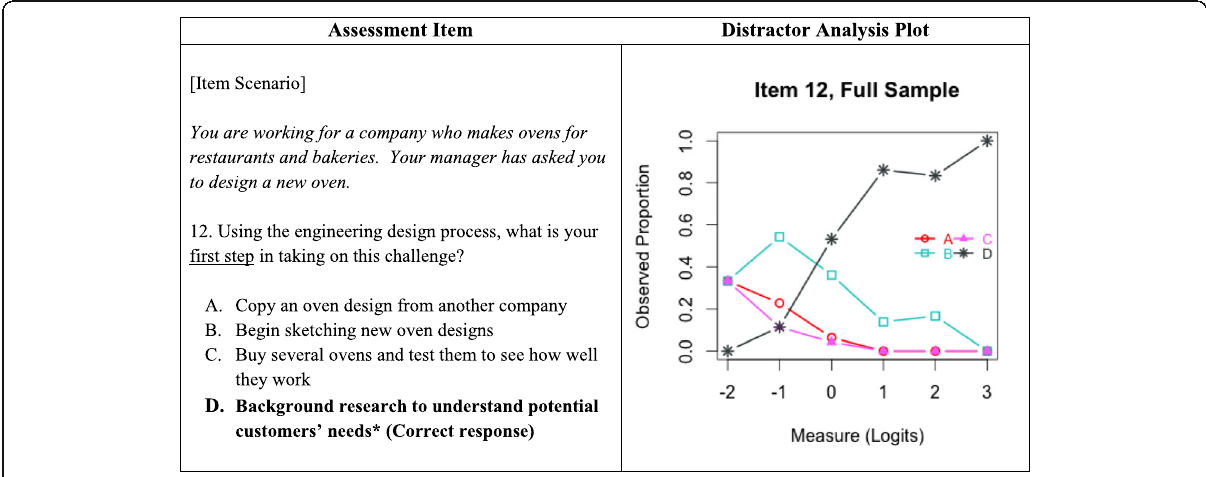
Fig. 3 Distractor analysis plot for item 12: full sample. The plot shows patterns of student answer choices for item 12 within the entire sample. The x -axis displays estimates of student achievement. Student achievement estimates are shown in logits, and these estimates were calculated using the Rasch model. Low values indicate lower achievement, and high values indicate higher achievement. The y -axis shows the observed proportion of responses for a given answer choice. The lines in the plot show the proportion of students who selected each of the four answer choices (A, B, C, or D) at each level of achievement. For this item, the correct response is D (black line with asterisk plotting